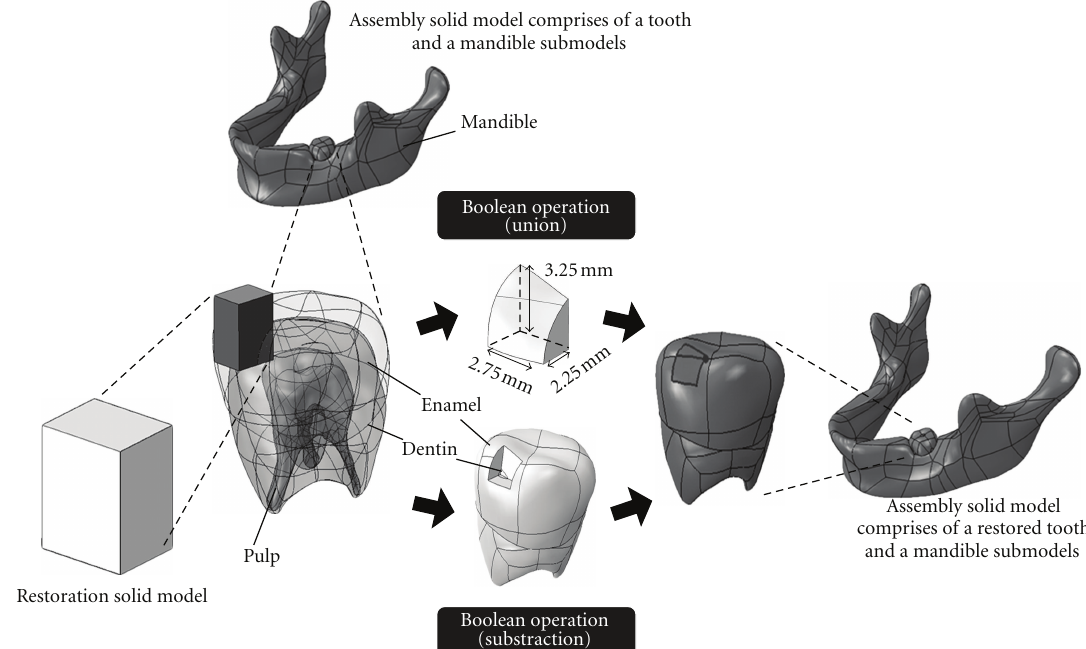
Figure 10: Processes involved in the assembly modeling procedure.